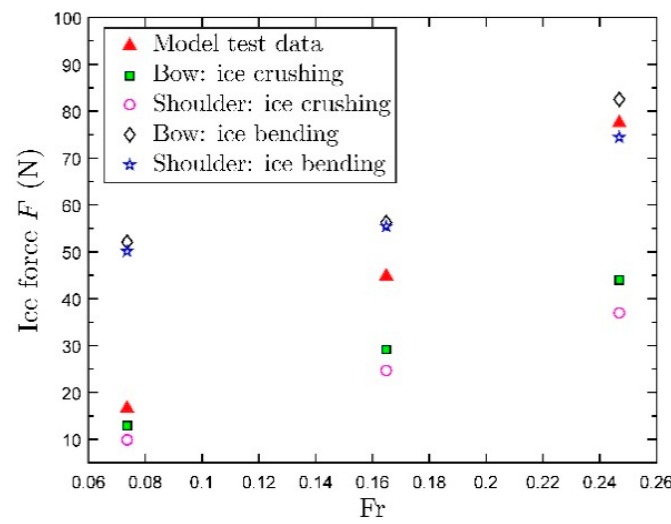
Figure 19. Comparison among model test data and ice failure force components.